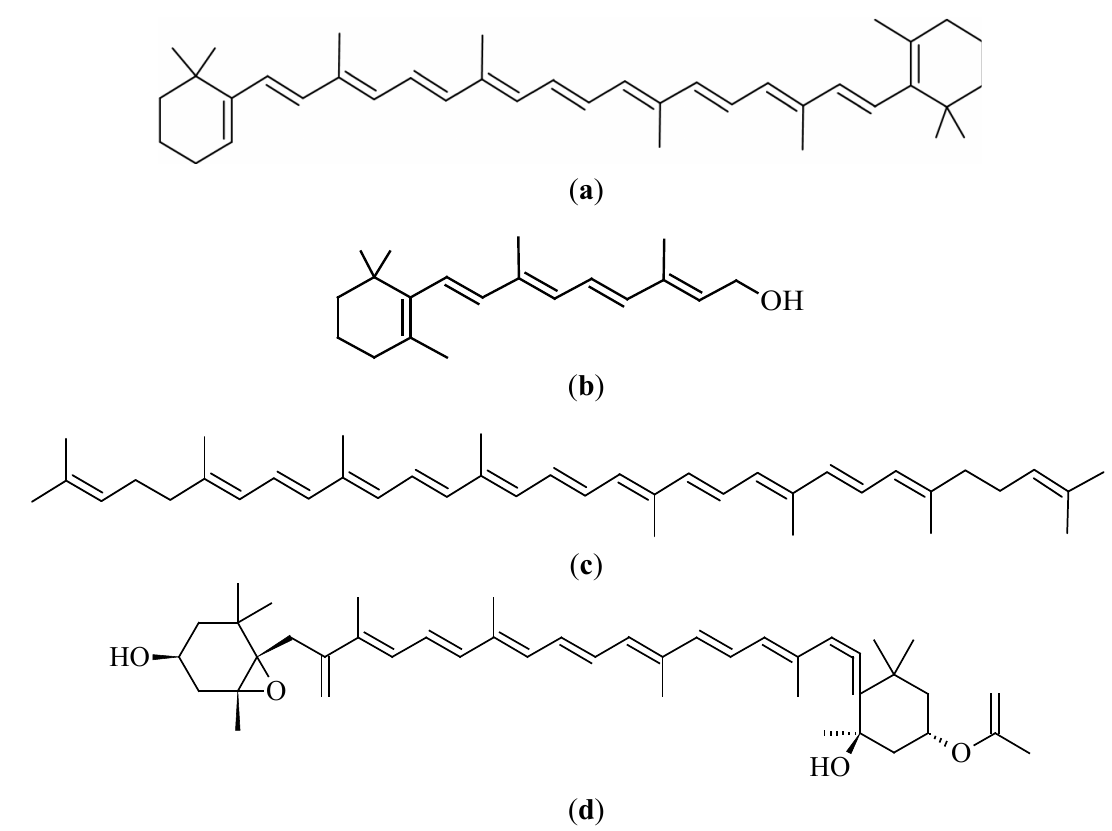
Figure 3. Chemical structures of selected carotenoids: ( a ) β -carotene, ( b ) retinol, ( c ) lycopene and ( d )